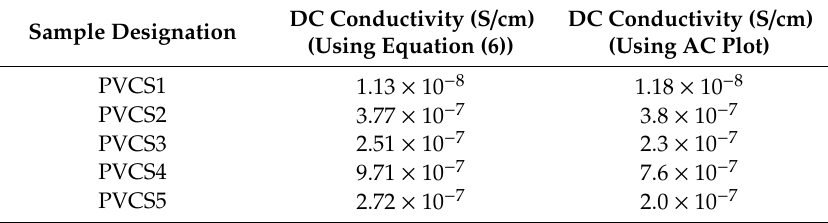
Figure 5. Complex impedance plots for ( a ) PVCS 1, ( b ) PVCS 2, ( c ) PVCS 3, ( d ) PVCS 4 and ( e ) PVCS 5. Table 2. DC conductivity for PVA:CS:NH 4 I blend electrolyte films from Equation (6) and AC conductivity spectra at room temperature.